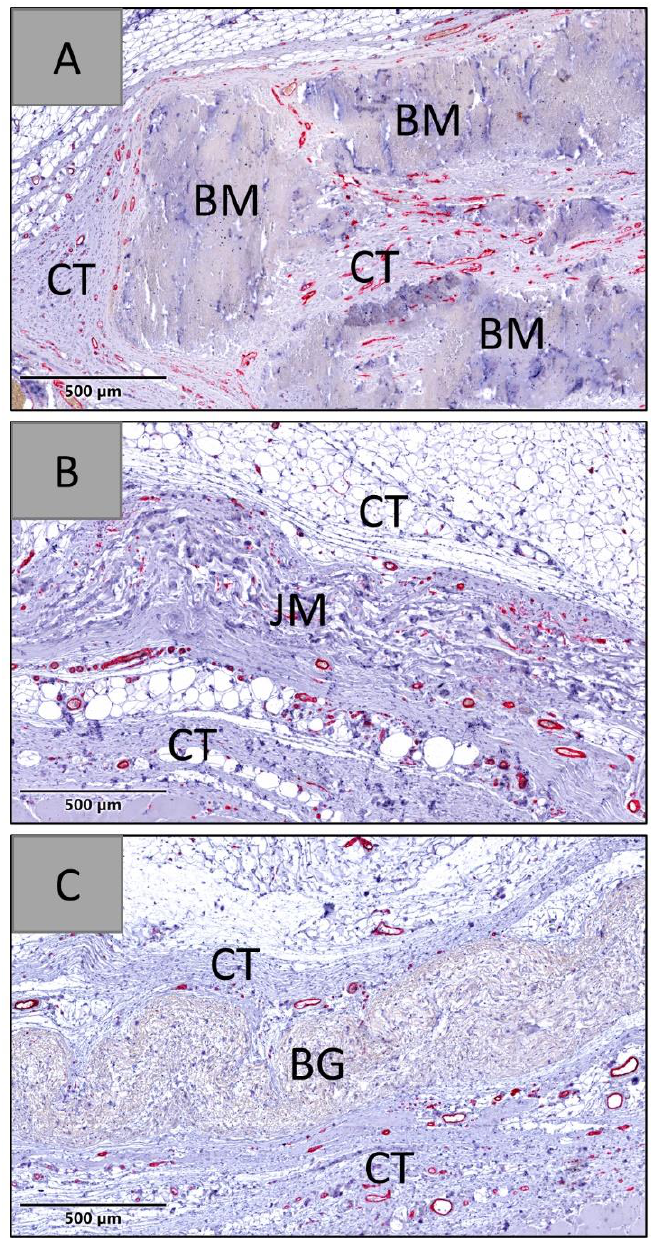
Figure 14. Exemplary histological images of the three membranes within the subcutaneous connective tissue (CT) at day 60 post implantationem. ( A ) BM = native bovine membrane, ( B ) JM = Jason ® membrane, ( C ) BG = Bio-Gide ® (CD31-immunostainings, 20× magnifications, scalebars = 500 µm). At day 90 post implantationem, significantly higher vessel numbers detected in the group of the native bovine membrane compared to the values in the other study groups (** p < 0.01 and *** p < 0.001) (Figure 16 and Table 11). The values in the groups of the Bio-Gide ® membrane group and the Jason ® membrane group did not significantly